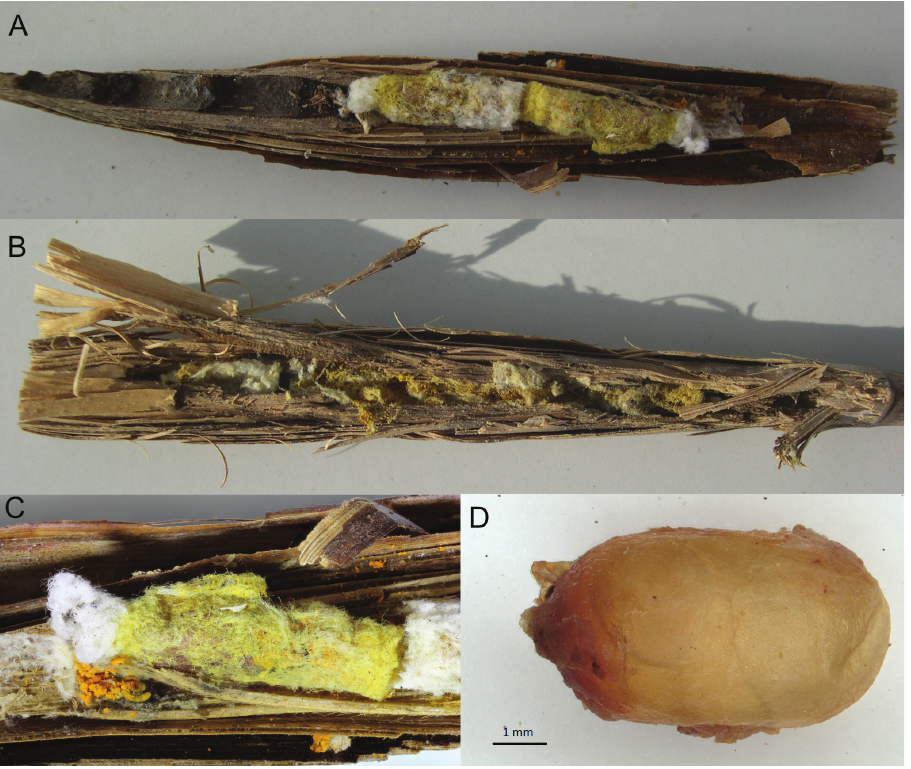
Figure 2. Nests of Pseudoanthidium tenellum inside a reed gall A, B entire gall with nest C detail on a brood cell with faeces, and D